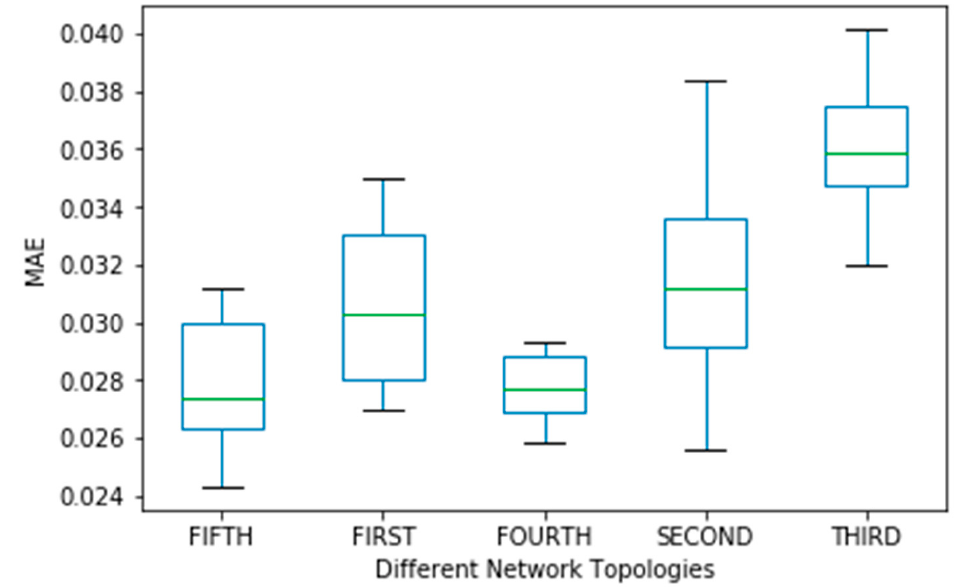
Figure 14. MAE vs. different network topologies.